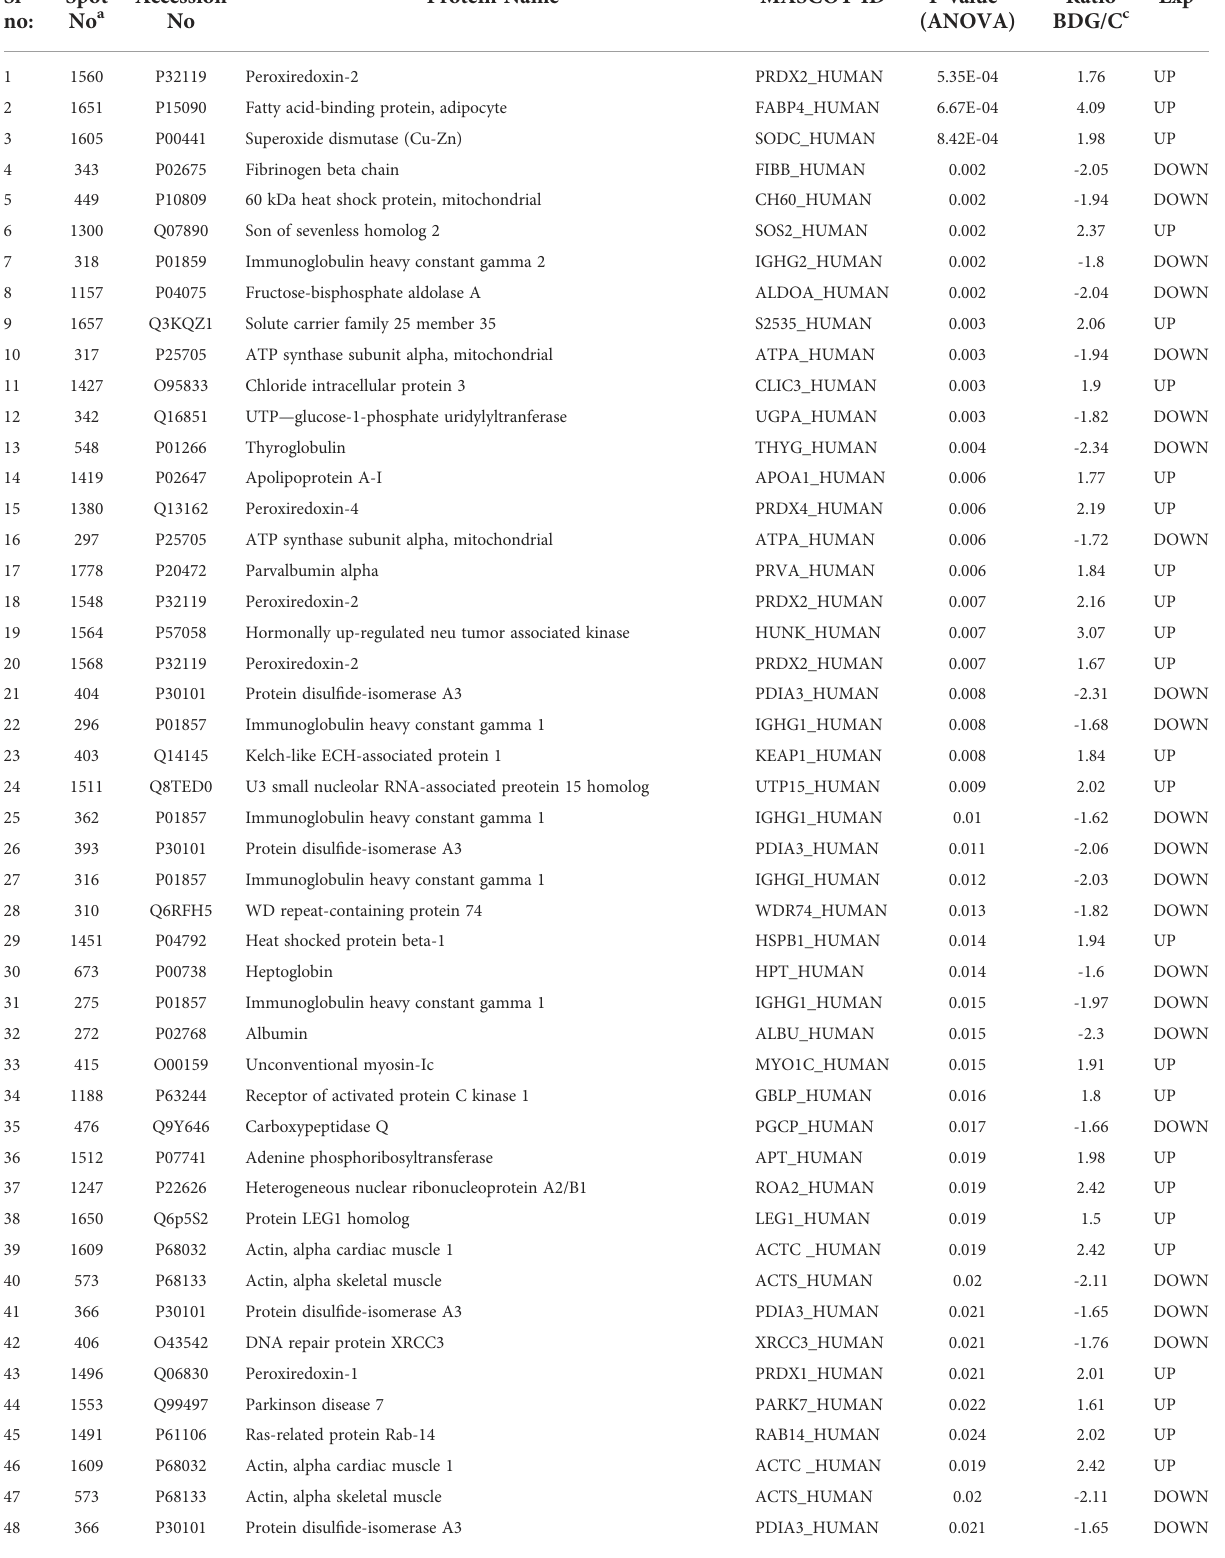
TABLE 2 Proteins identi fi ed in thyroid tissue samples with differences in abundance between BDG and control